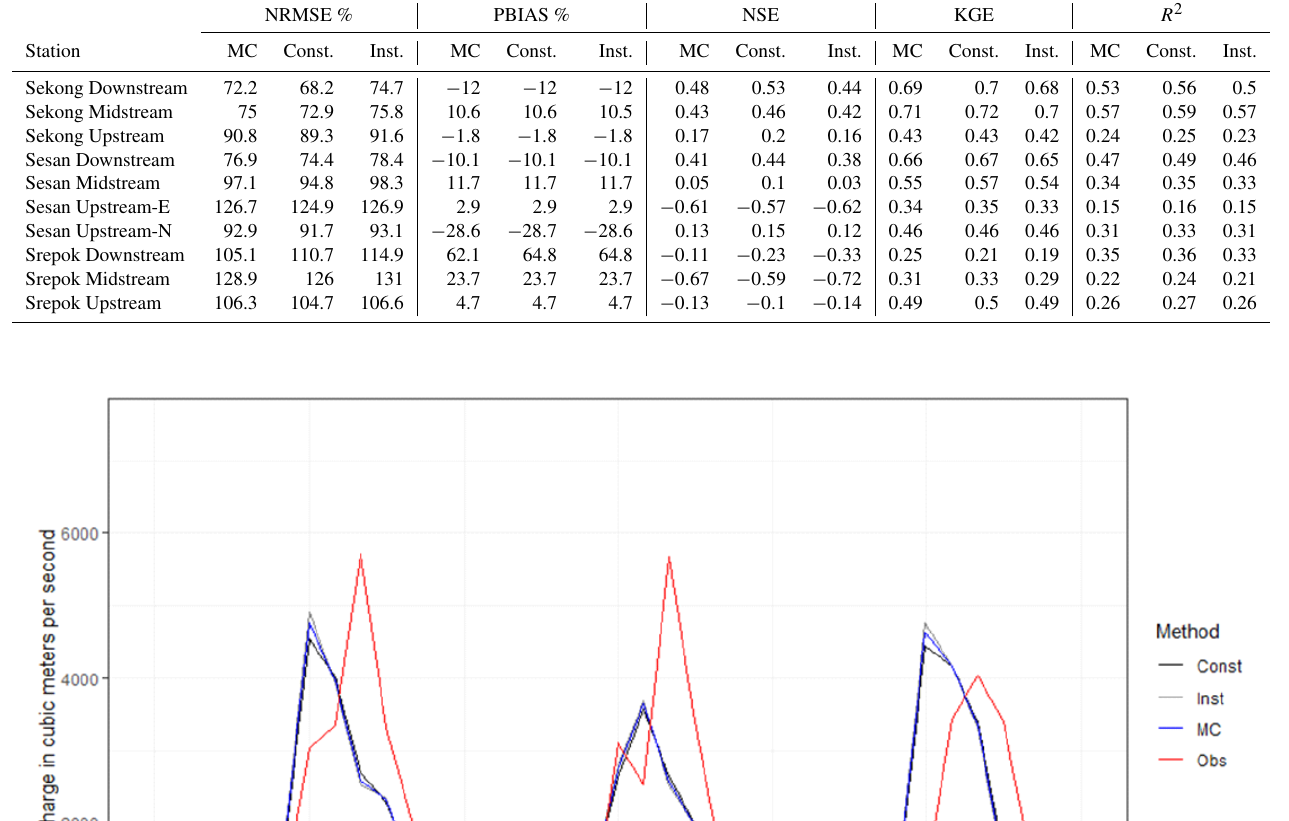
Table B1. Performance metrics of the three routing methods implemented in Hydrostreamer for the GHM LPJmL forced with GSWP3 climate dataset. MC stands for Muskingum–Cunge algorithm, Const. for constant velocity routing and Inst. for instantaneous routing.